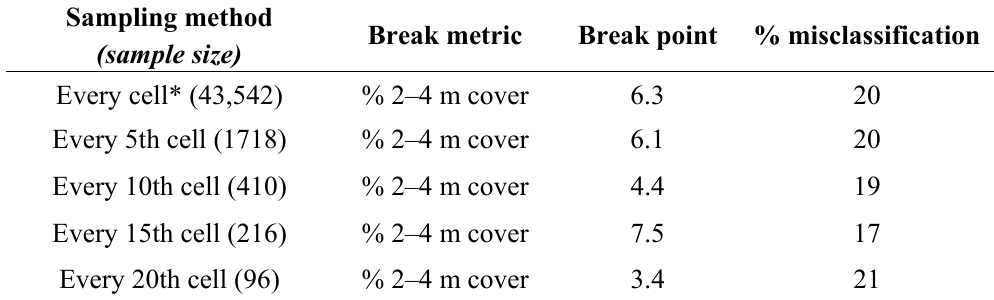
Table 3. Results from classification tree analyses at a range of spatial sampling scales, describing the break point metric, the break point value, and the misclassification rate for the pruned tree (compared to 50% misclassification in the null model); *Only one pruned classification tree (every cell) had more than one break; In this case, the full model had three breaks (in order, these breaks were 2–4 m cover, slope in degrees, and percentage of point heights above 3 meters, with breakpoints at 6.3%, 22°, and 70%, respectively), with a misclassification rate of 18% (compared to 20% using only the first break).